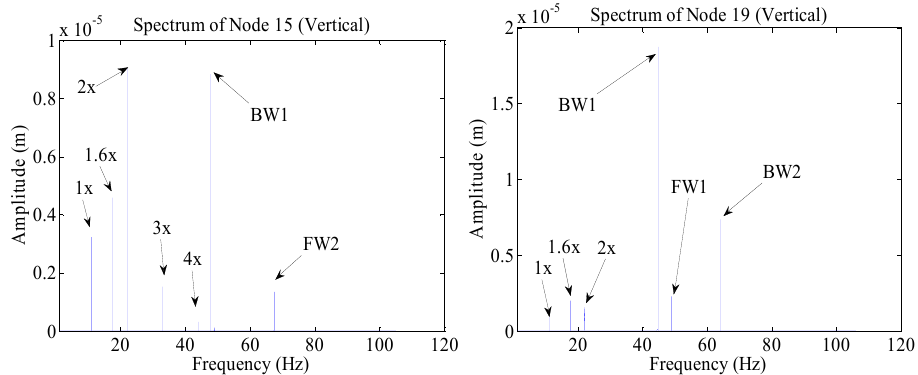
Figure 14. The spectrum of Bearing 3 and Bearing 4 (without bearing damping).